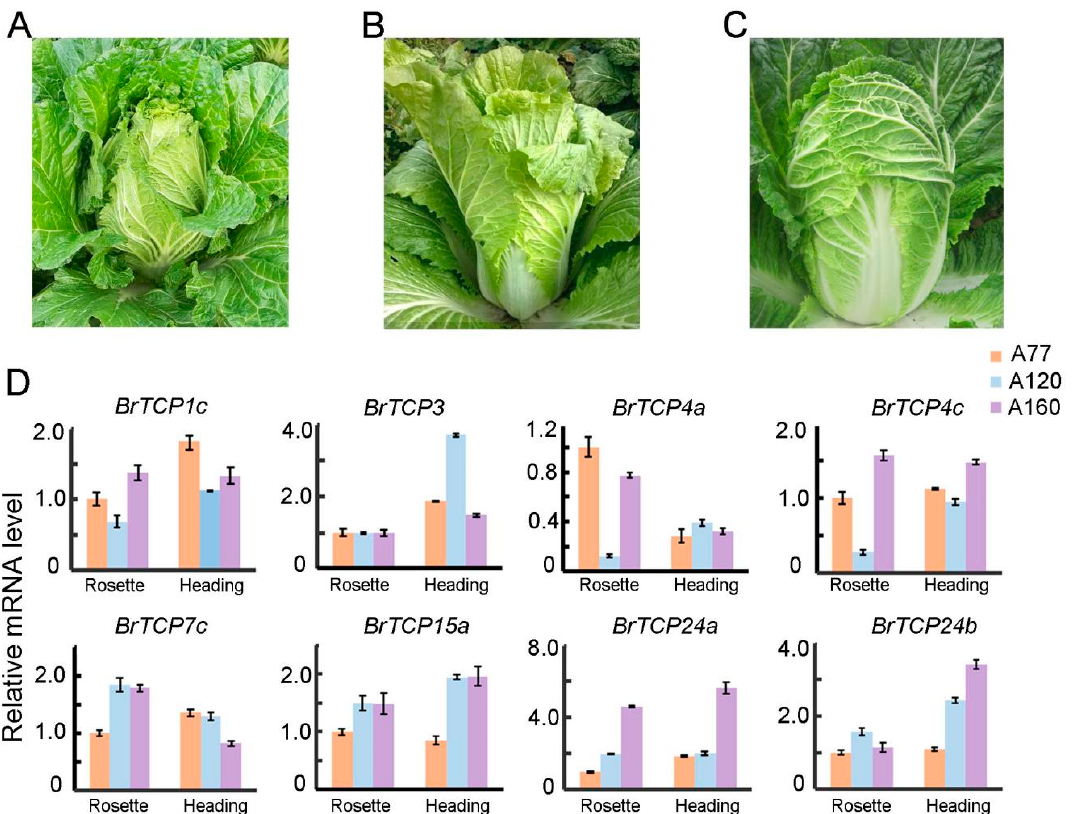
Figure 7. The expression level of BrTCP genes in leaves of different heading types of Chinese cabbages: ( A ) the inbred line of A120 Chinese cabbage at heading stage; ( B ) the inbred line of A77 Chinese cabbage at heading stage; ( C ) the inbred line of A160 Chinese cabbage at heading stage; and ( D ) the expression level of BrTCP1c , BrTCP3 , BrTCP4a , BrTCP4c , BrTCP7c , BrTCP15a , BrTCP24a , and BrTCP24b in the inbred lines of A120, A77, and A160 at rosette and heading stages. The represent results performed in triplicate. Error bars represent ±